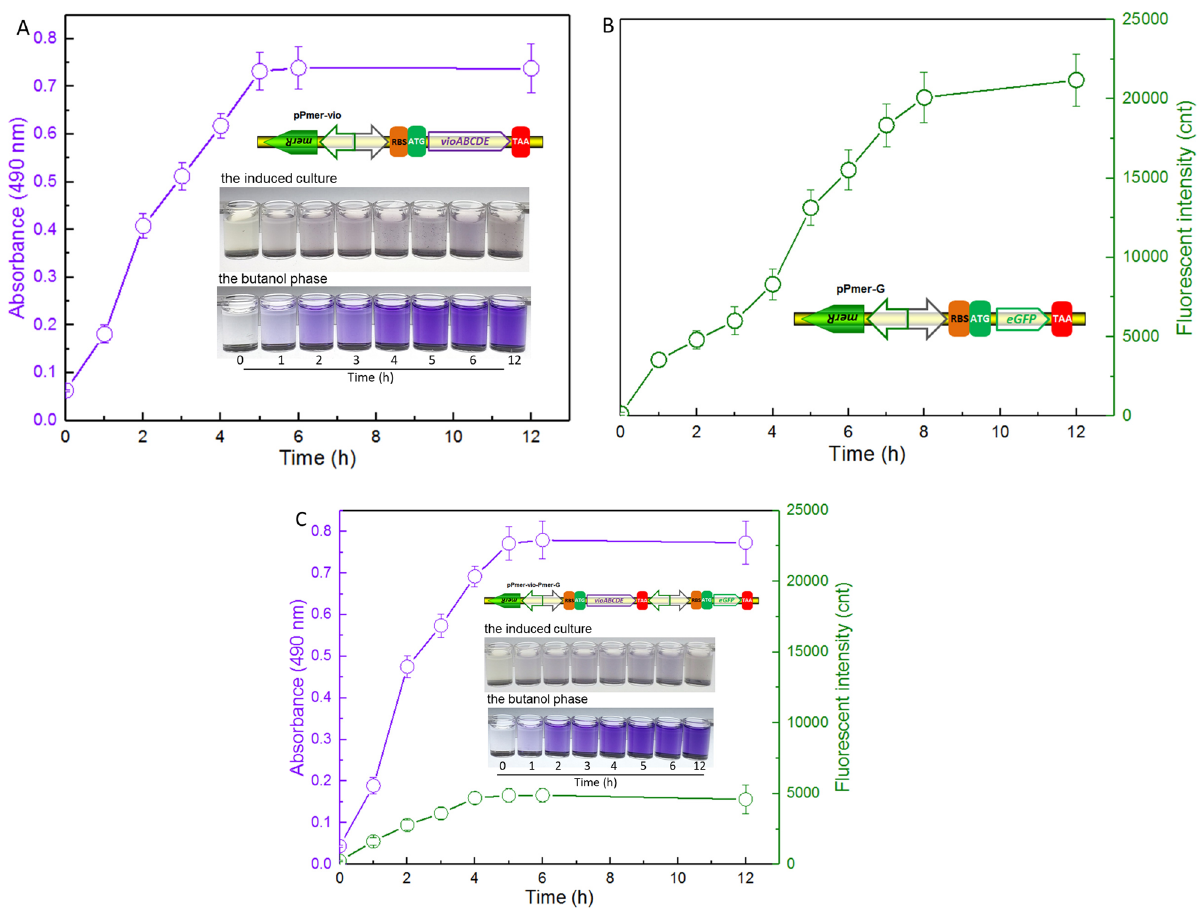
Figure 4. Time courses of reporter signals generated by three whole-cell biosensors with 8 μM Hg(II) exposure. Quantitative time-course profiles of whole-cell biosensors TOP10/pPmer-vio ( A ), TOP10/pPmer-G ( B ), and TOP10/pPmer-vio-Pmer-G ( C ) to Hg(II). Three kinds of bacterial cells in exponential growth phase were exposed to 8 μM Hg(II) at 37 o C. The fluorescent signal and pigment-based color change were detected at regular time intervals. Both of the reporter signals were normalized to bacterial cell density at 600 nm. The results are shown as the mean of three independent assays ± the standard